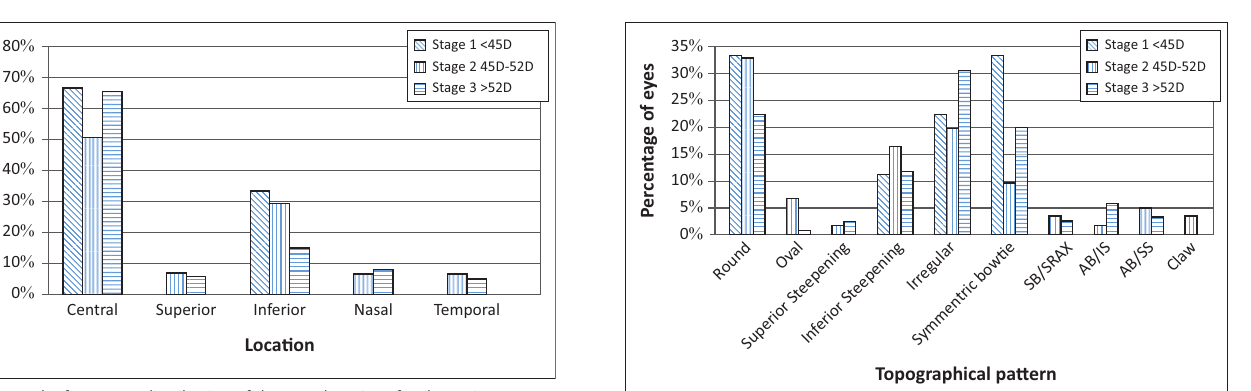
FIGURE 4: The frequency distribution of cone topographical patterns versus stage of